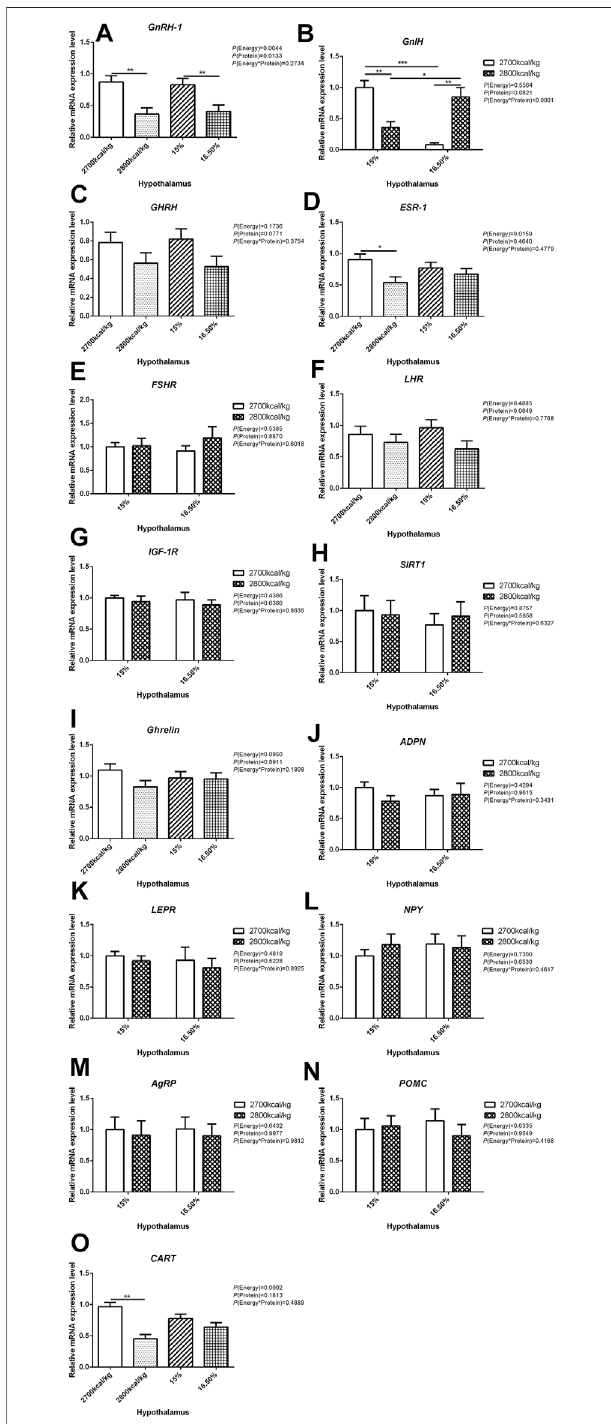
FIGURE 1 | Effect of dietary metabolizable energy (E) and crude protein (P) levels during the prelay period (15 – 20 weeks of age) on the mRNA expression of genes GnRH-1 (A) , GnIH (B) , GHRH (C) , ESR-1 (D) , FSHR (E) , LHR (F) , IGF-1R (G) , SIRT1 (H) , Ghrelin (I) , ADPN (J) , LEPR (K) , NPY (L) , AgRP (M) , POMC (N) , and CART (O) in the hypothalamus of hens. Data represent the mean ± SD ( n = 4); p p < 0.05, pp p < 0.01, ppp p <